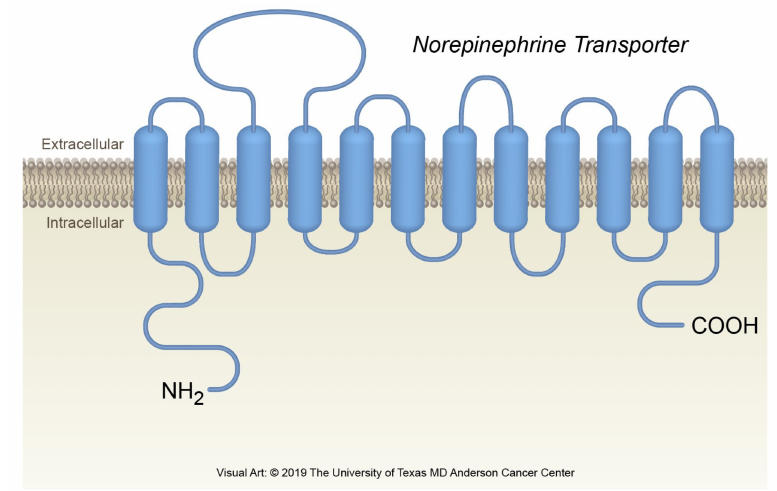
Figure 2. The norepinephrine transporter.